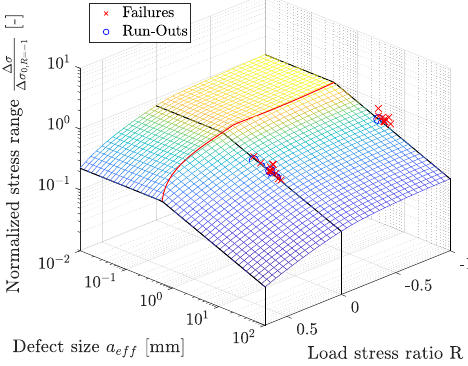
Figure 25. GKD for FT#B defects enhanced by the mean stress